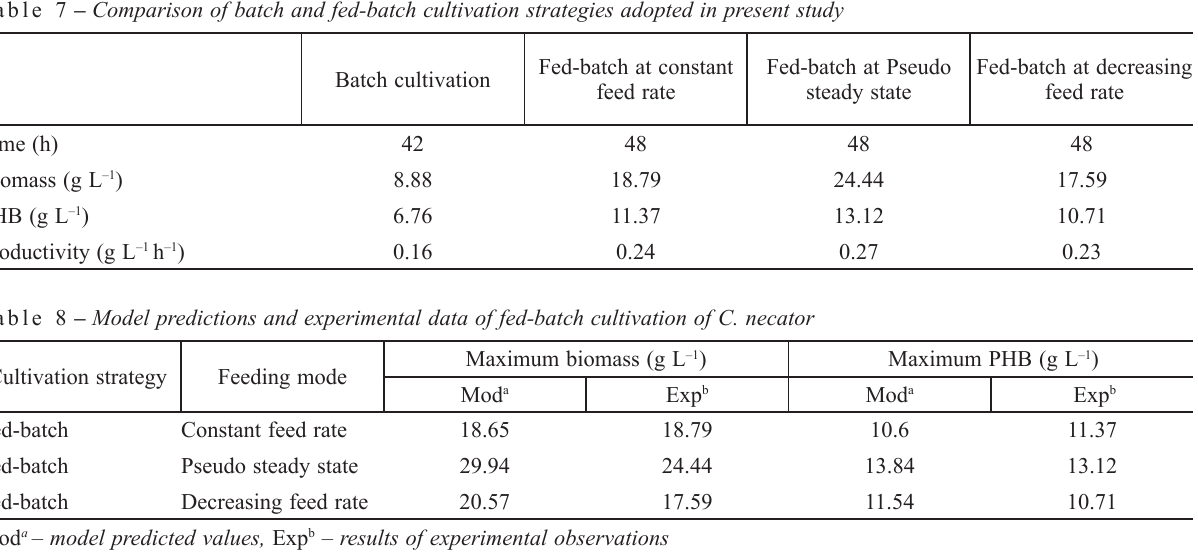
Table 7 – Comparison of batch and fed-batch cultivation strategies adopted in present study Batch cultivation